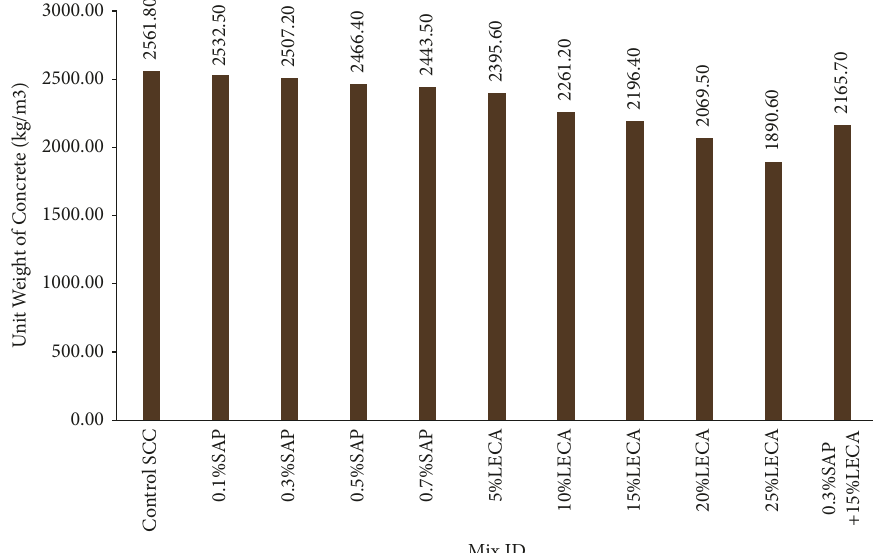
Figure 15: Unit weight of all SCC